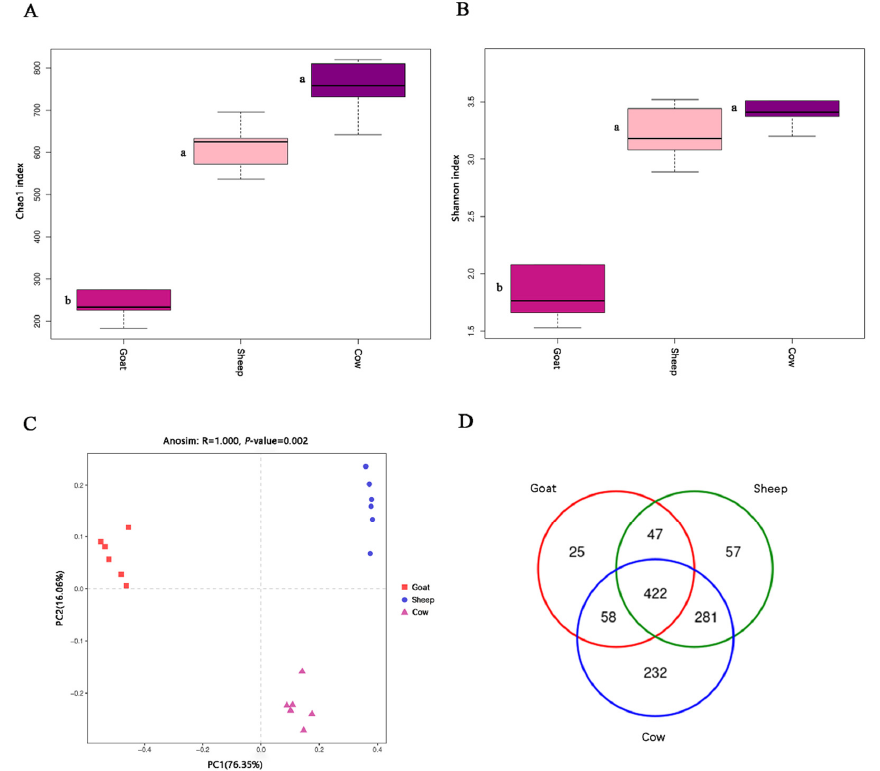
Figure 1. Diversity analysis of rumen bacterial community in goats, sheep, and cows. (A)